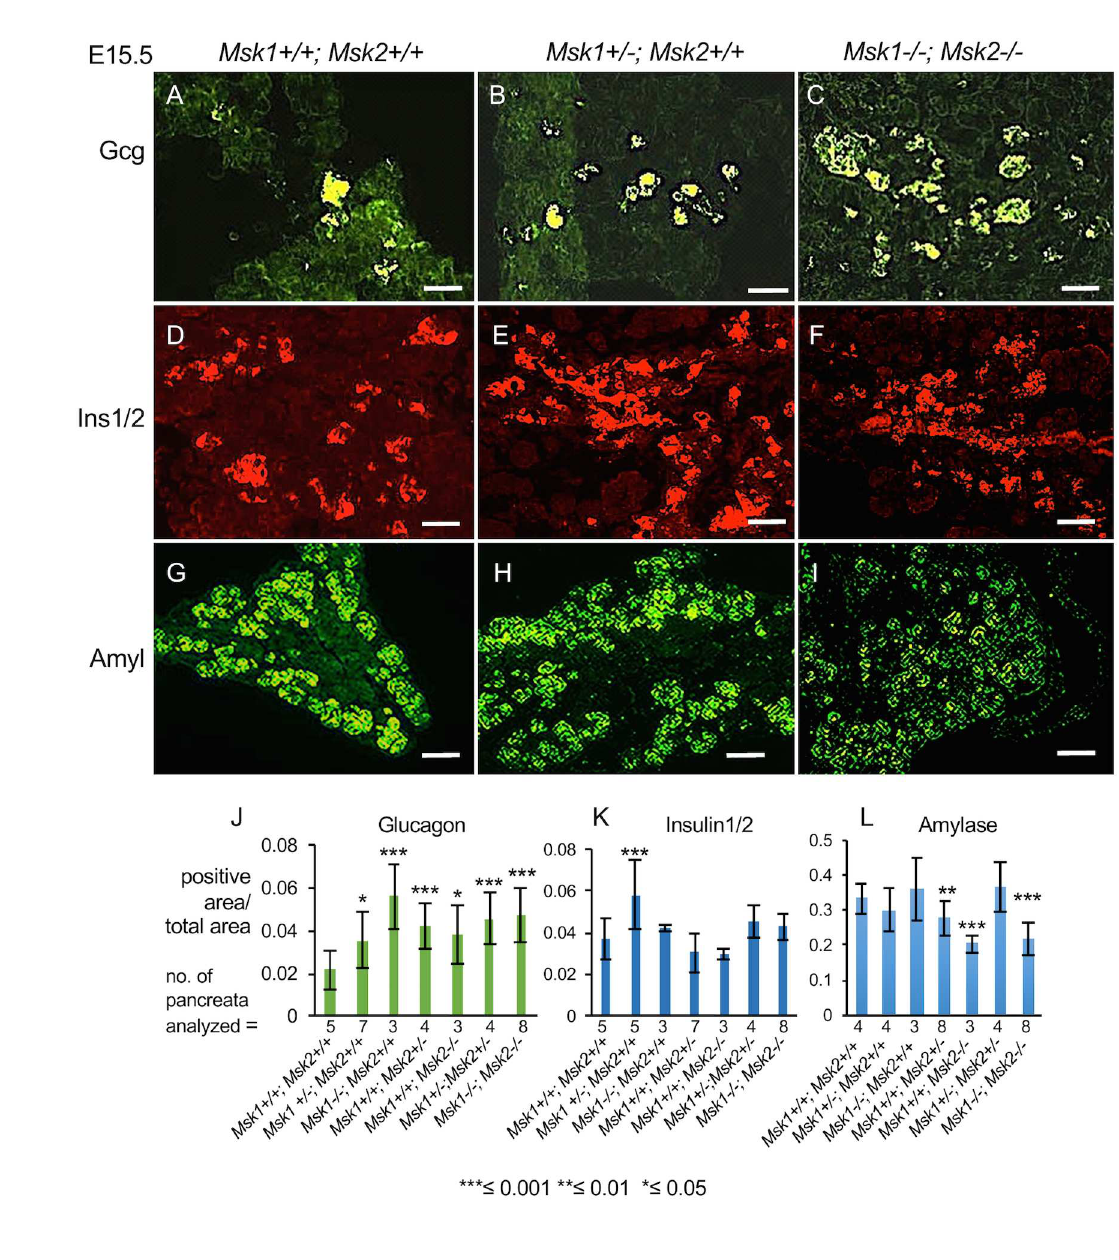
Fig 9. MSK1 and MSK2 proteins have distinct functions during pancreatic development. (A-I) Representative images showingexpressionof Glucagon(A-C, scale bar = 50 μ m),Insulin (D-F, scale bar = 50 μ m)and Amylase (G-I, scale bar = 100 μ m,)in the indicatedgenotypesat E15.5. (J-L) Glucagon,Insulin, and Amylase positive areas normalizedto total area in the indicatedgenotypes at E15.5. For Gcg, P-values are 0.01 for Msk1+/- , 3.3x10 -7 for Msk1-/- , 2.2x10 -4 for Msk2+/- , 0.02 for Msk2-/- , 2.2x10 -6 for Msk1+/- ; Msk2+/- and 3.1x10 -5 for Msk1-/-;Msk2-/- . For Ins1, P-value = 1.5x10 -5 for Msk1+/- . For Amyl, P-values are 3.3x10 -13 for Msk2+/- , 0.004 for Msk1+/- ; Msk2+/- , 1.7 x10 -6 for Msk1-/- ; Msk2-/- . Average number of sections/ pancreas for Ins1 and Gcg respectivelywere 17, 9.8 (wild type), 17.83, 5.6 ( Msk1+/- ), 15.6, 5 ( Msk1-/- ), 16.3, 5 ( Msk2-/- ), 14.75, 6.375 ( Msk2+/- ), 13, 13.5 ( Msk1+/-; Msk2+/- ), 15.12, 6.75 ( Msk1-/-; Msk2-/- ). All P-values were calculatedby Student’st test, relativeto wild type controls, * (cid:20) 0.05, ** (cid:20) 0.01, *** (cid:20) 0.001, two-tailedunequalvariance,two-tailed. Valuesare averages of independent experiments ± standard error unless otherwisestated.